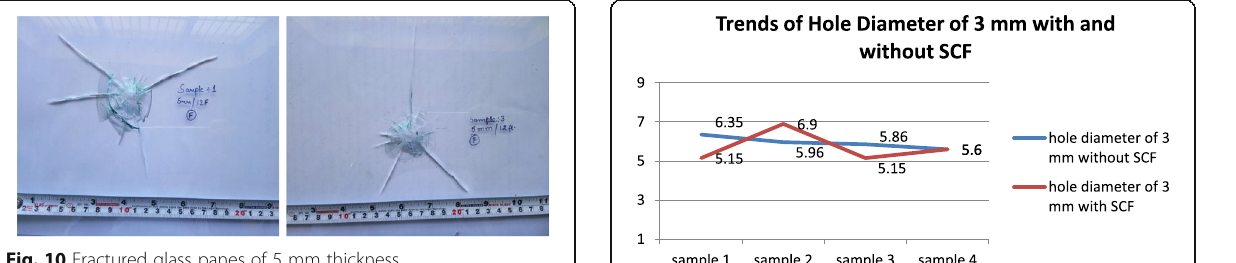
Fig. 10 Fractured glass panes of 5 mm thickness